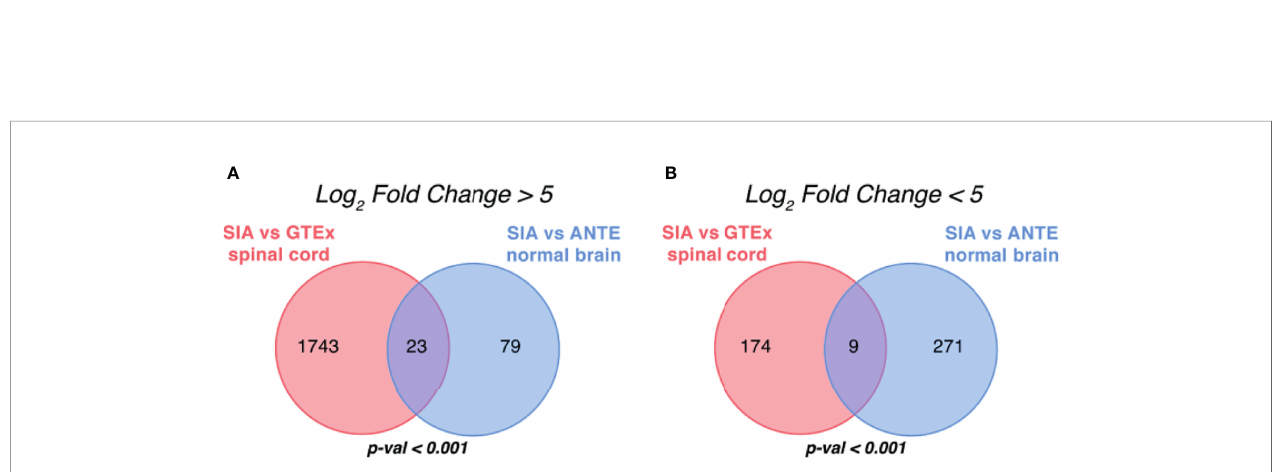
FIGURE 2 | Distribution of differentially expressed genes between spinal intramedullary astrocytomas (SIAs) relative to (A) GTEx healthy spinal cord and (B) ANTE healthy brain samples.